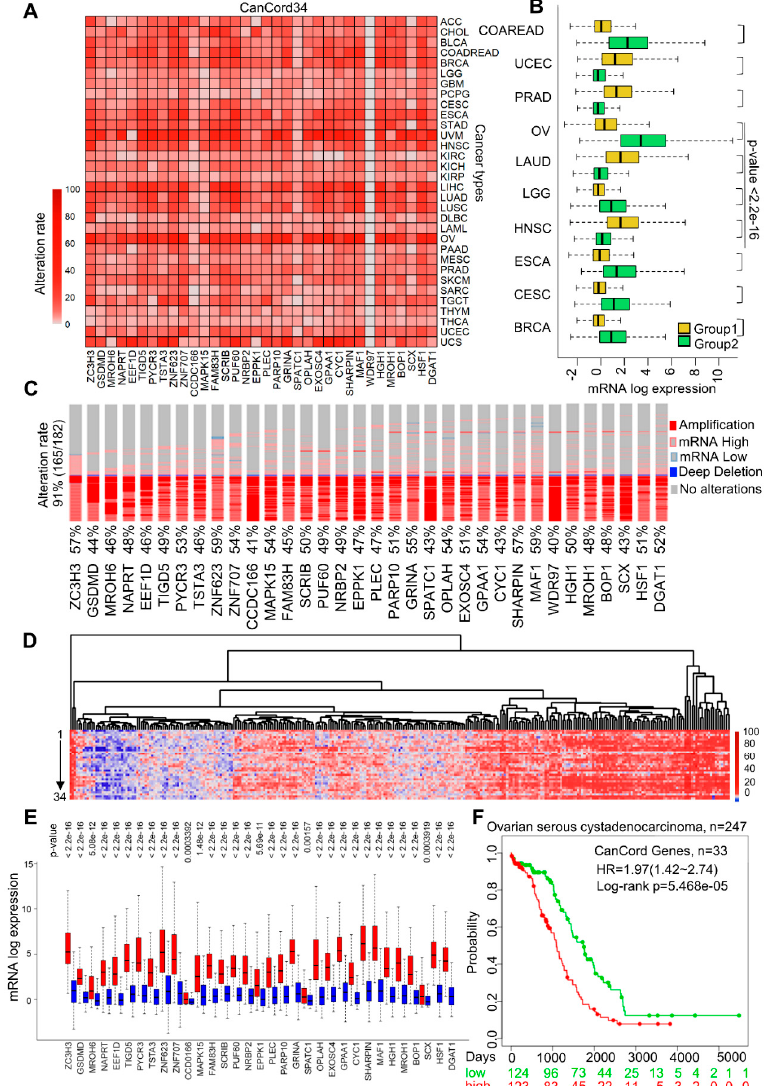
Figure 2. All-encompassing pattern of CanCord34. ( A ) A single-color heatmap represents the alteration rate of CanCord34 genes in 33 different cancer types. The increasing intensity of the color gradient is directly proportional to the increasing alteration rate. The X-axis represents the genes, and the Y-axis represents the TCGA abbreviation for the 33 cancer types. ( B ) Boxplot representation of the expression distribution of CanCord34 genes at the mRNA level for different cancers. Each cancer type was classified into two distinct groups based on CanCord34 expression. ( C ) Dispersal of alterations in the CanCord34 genes in ovarian cancer patients. Each row represents a gene, and each vertical line represents each patient sample. These genes are coordinately upregulated in patients at the mRNA level. The alterations are represented with different color codes and patterns. The data were taken from cBioPortal. ( D ) Heatmap representation of CanCord34 gene expression at the mRNA level, constructed using the heatmap algorithm of R for the ovarian cancer data. ( E ) Boxplot representation of the expression distribution between two groups identified using k-means clustering for each gene. The significance of the noticed difference between the gene expression levels was evaluated using the Mann–Whitney–Wilcoxon test. ( F ) Kaplan–Meier survival plot for the CanCord34 genes generated using the SurvExpress